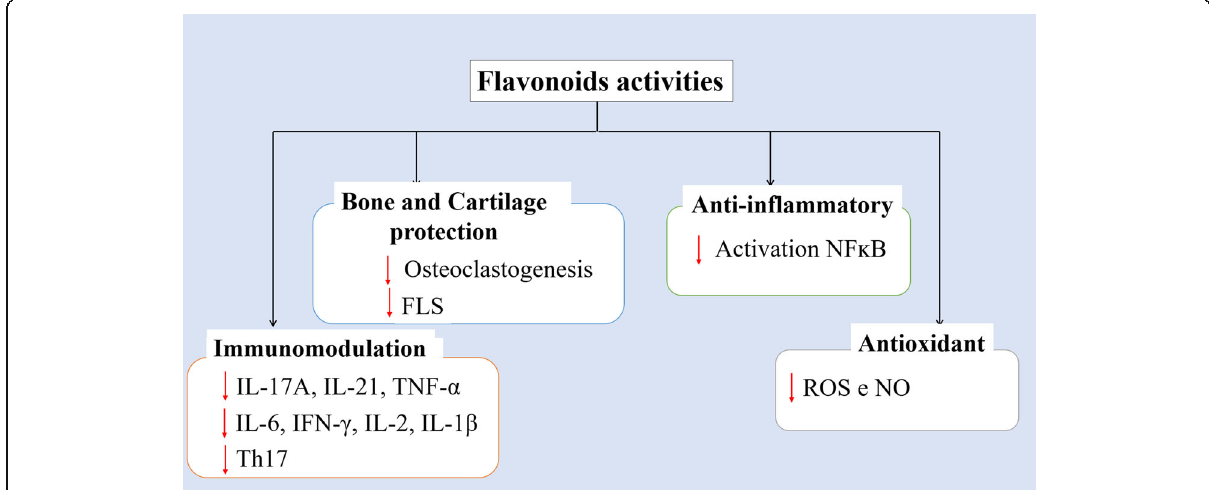
Fig. 1 Biological activities of flavonoids in RA. Legends: FLS- fibroblast-like synoviocytes, NFkB - nuclear factor ĸ B, IL- interleukin, IFN - interferon, TNF - tumor necrosis factor, ROS - reactive oxygen species and NO - nitric